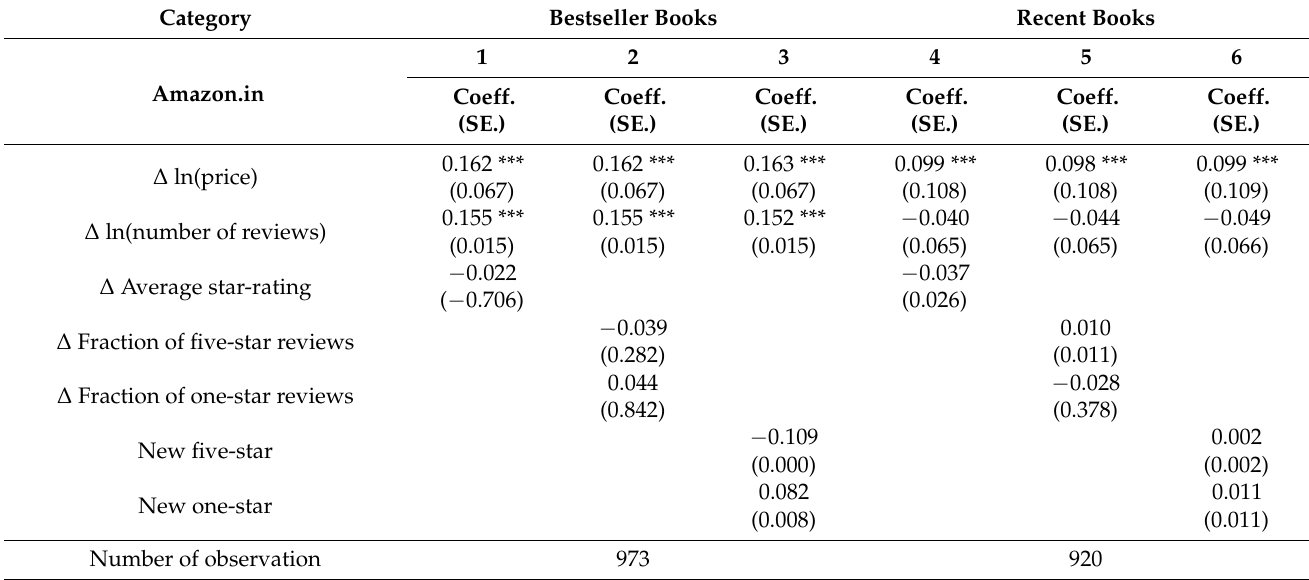
Table 4. Effect of two-month change in reviews on sales of